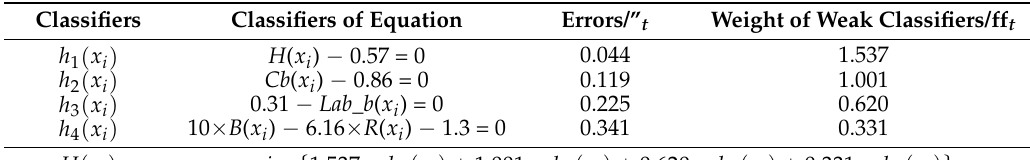
Table 1. The error rate of weak classifiers and their weights in the final strong